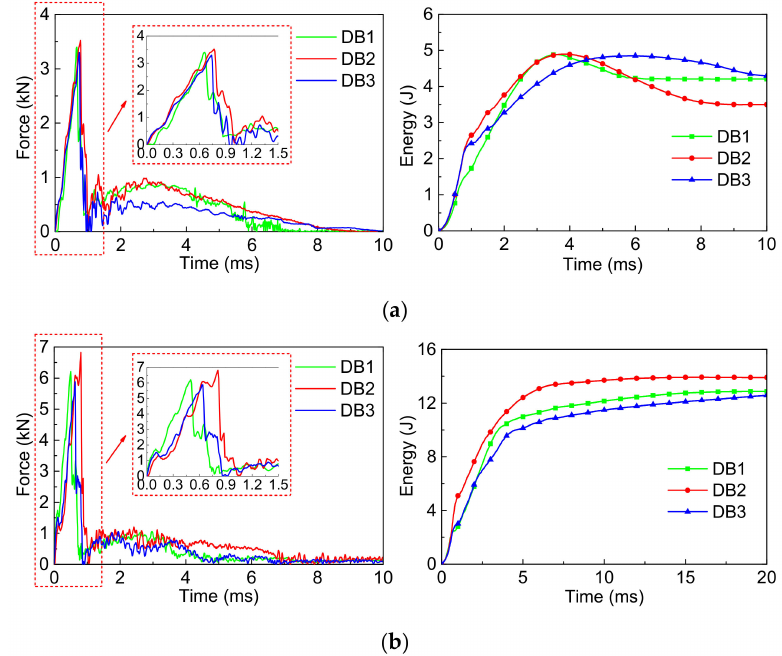
Figure 15. The force-time curves and energy-time curves of composites with different SMA diameters and layup spacing under two impact energies: ( a ) Initial impact energy of 5 J; ( b ) Initial impact energy of 14 J.